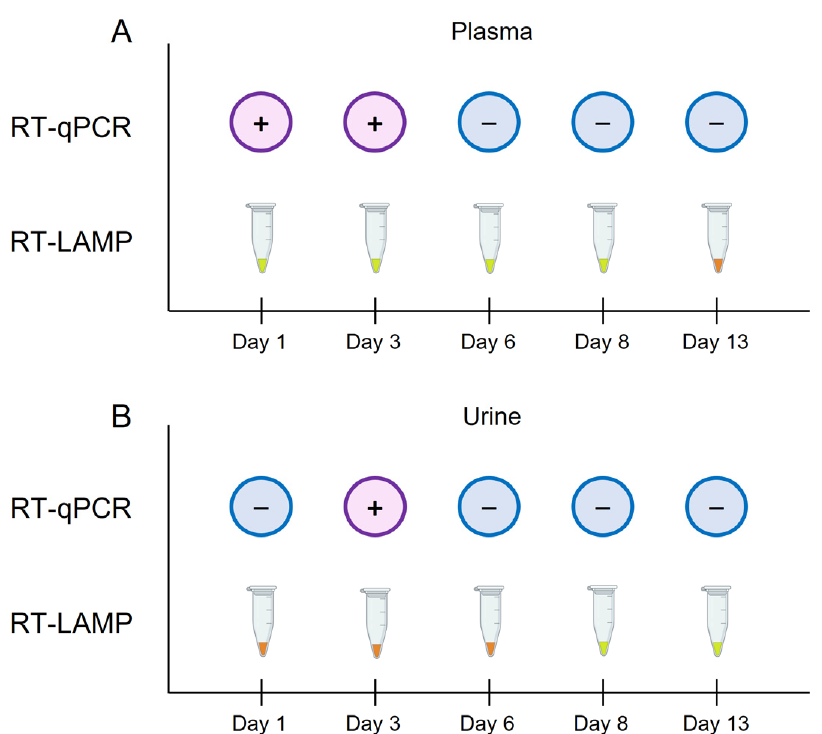
Figure 4. Schematic representation of the comparison of the results obtained by RT-qPCR and colorimetric RT-LAMP in plasma and urine samples from patient P4 over days 1, 3, 6, 8 and 13, during the patient’s admission at hospital. ( A ) Results obtained by RT-qPCR vs. RT-LAMP in plasma samples. ( B ) Results obtained by RT-qPCR vs. RT-LAMP in urine samples. For RT-qPCR, the + symbol in a purple circle indicates a positive result; the − symbol in a blue circle indicates a negative result. For colorimetric RT-LAMP, the results were visually detected by colour change: green/positive;